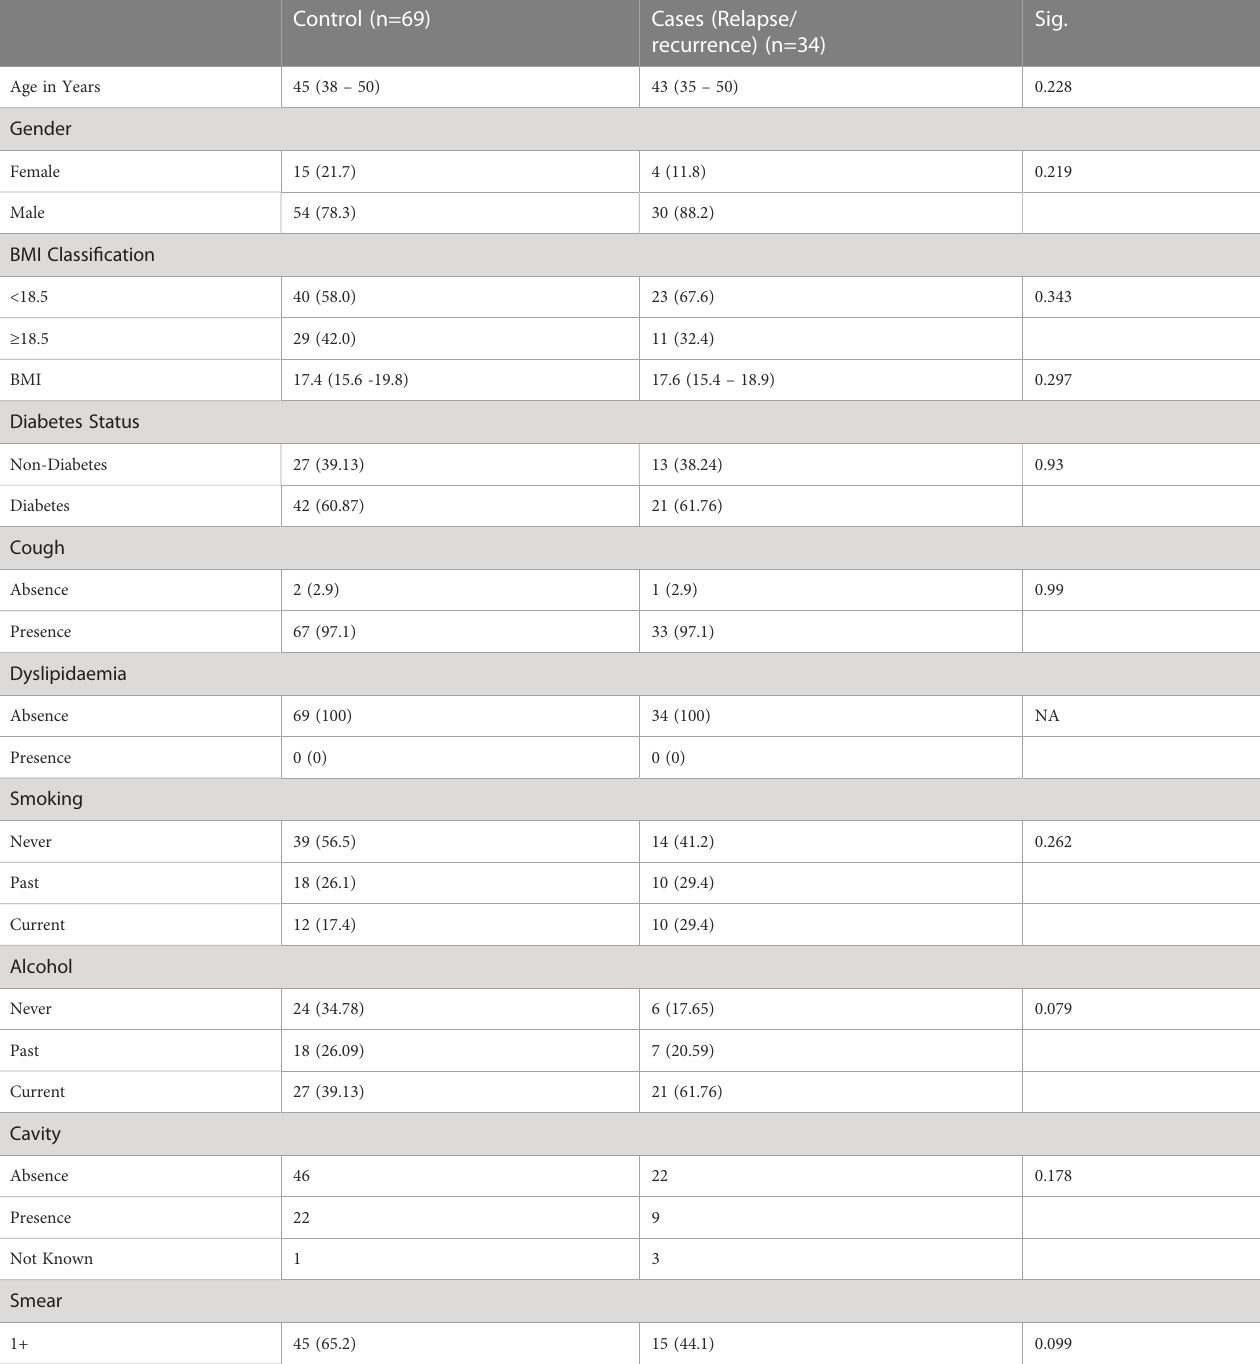
TABLE 1B Patients characteristics for individuals with TB